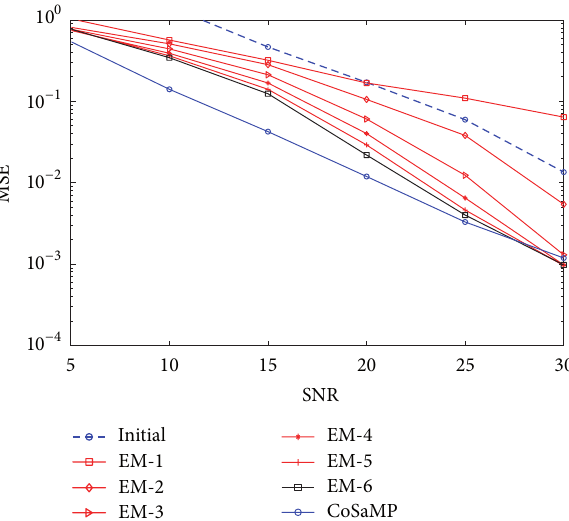
Figure 3: MSEperformance of channel estimation at T 1 when 𝑑 = 4 .